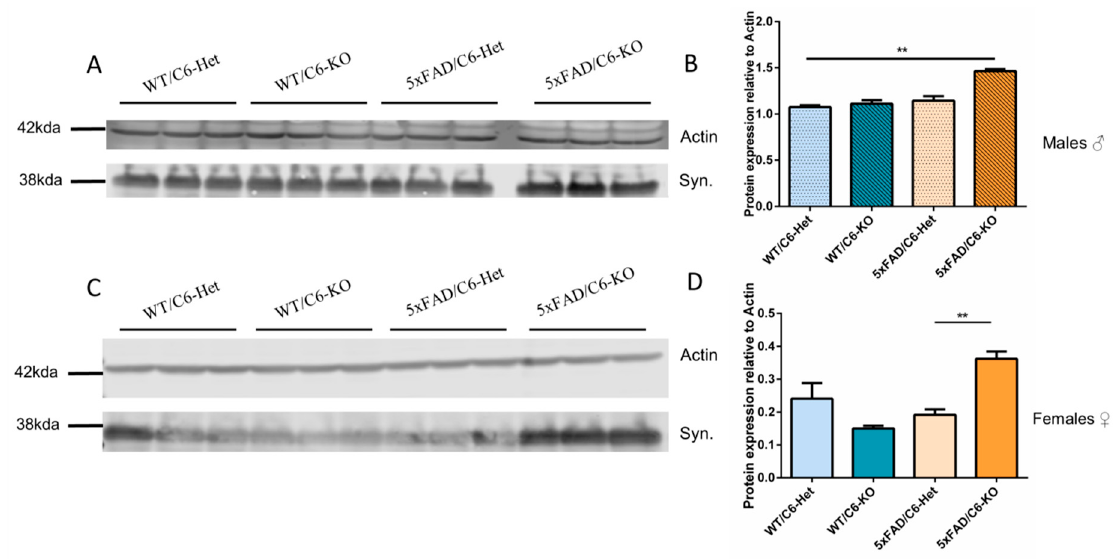
/ C6-KO double transgenic mice. Syn: Figure 4. Synaptophysin is increased in 5xFAD/C6-KO double transgenic mice. Syn: Synaptophysin. Figure 4. Synaptophysin is increased in 5xFAD